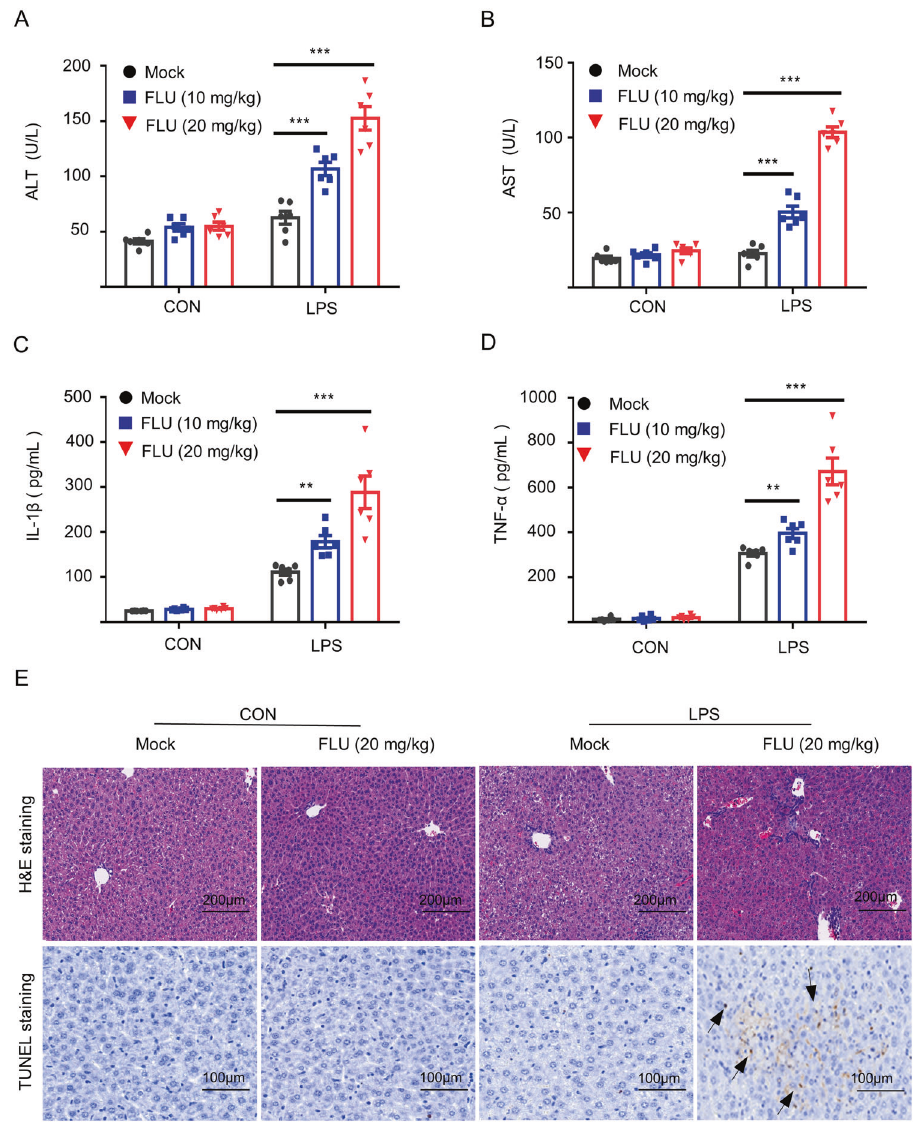
Fig. 5 Fluoxetine induces hepatic injury via triggering the activation of the NLRP3 in fl ammasome in vivo. A – D WT C57BL/6 mice were injected with LPS (2 mg/kg) and then stimulated with fl uoxetine (10 mg/kg, 20 mg/kg, n = 6/group). The levels of mouse serum ALT ( A ) and AST ( B ) were measured by GTP and GOT kits, and IL-1 β ( C ) and TNF- α ( D ) were detected by ELISA kits. E H&E staining (scale bar: 200 μ m) and TUNEL staining (scale bar: 100 μ m) were used to assess in fl ammatory in fi ltration and TUNEL positive. Data are shown as the mean ± SEM. *P < 0.05, **P < 0.01, ***P < 0.001vs LPS group, ns, not signi fi cant. One-Way ANOVA analysis followed by Dunnett ’ s post-hoc